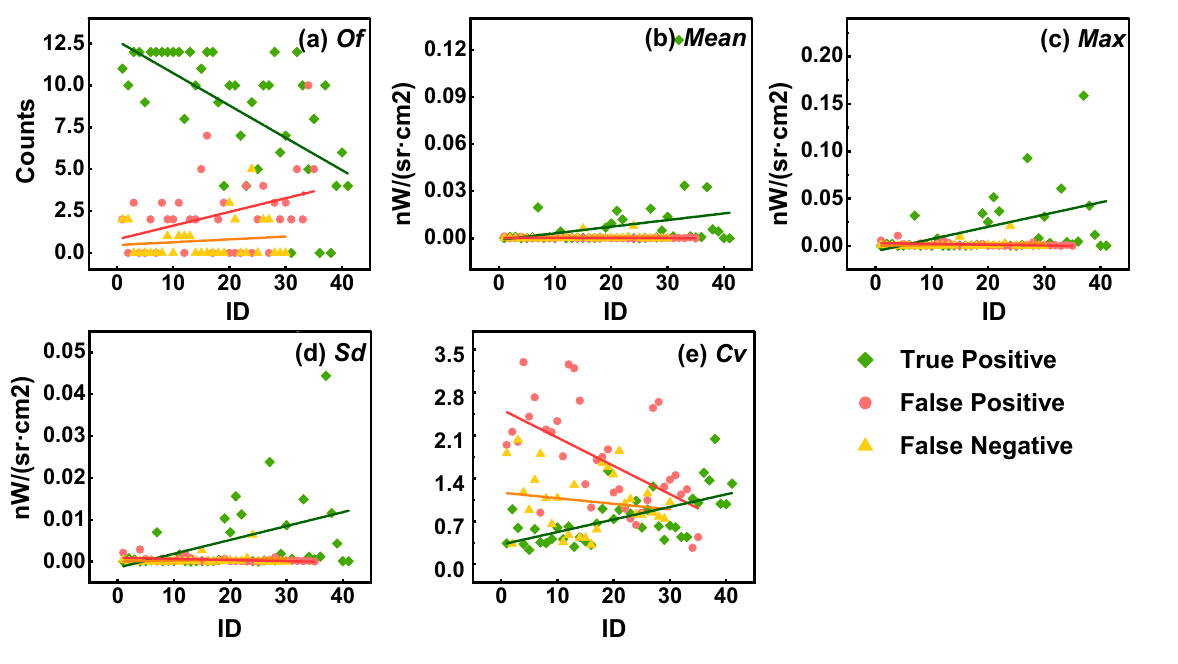
Figure 10. Feature distribution of each target in 2016: ( a ) is the occurrence frequency distribution; ( b ) is the mean distribution; ( c ) is the maximum distribution; ( d ) is the standard deviation distribution; and ( e ) is the coefficient of variation distribution. The green diamond indicates the correctly extracted targets, the red circle is the incorrectly extracted targets, and the yellow triangle is the omissive targets. The green line is the fitted line of the feature distribution for the correct targets; the red line is the fitted line of the feature distribution for the incorrect targets, and the orange line is the fitted line of the feature distribution for the omissive targets.